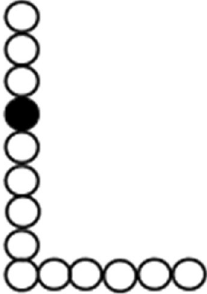
Figure 1. Visuospatial-temporal integration for shape-from-moving-dots. Each dot was presented for 1 s with no interval between presentations, i.e., the dots were displayed one at a time, which forced the subject to mentally integrate them across space and time to generate a complete object or letter, e.g.,